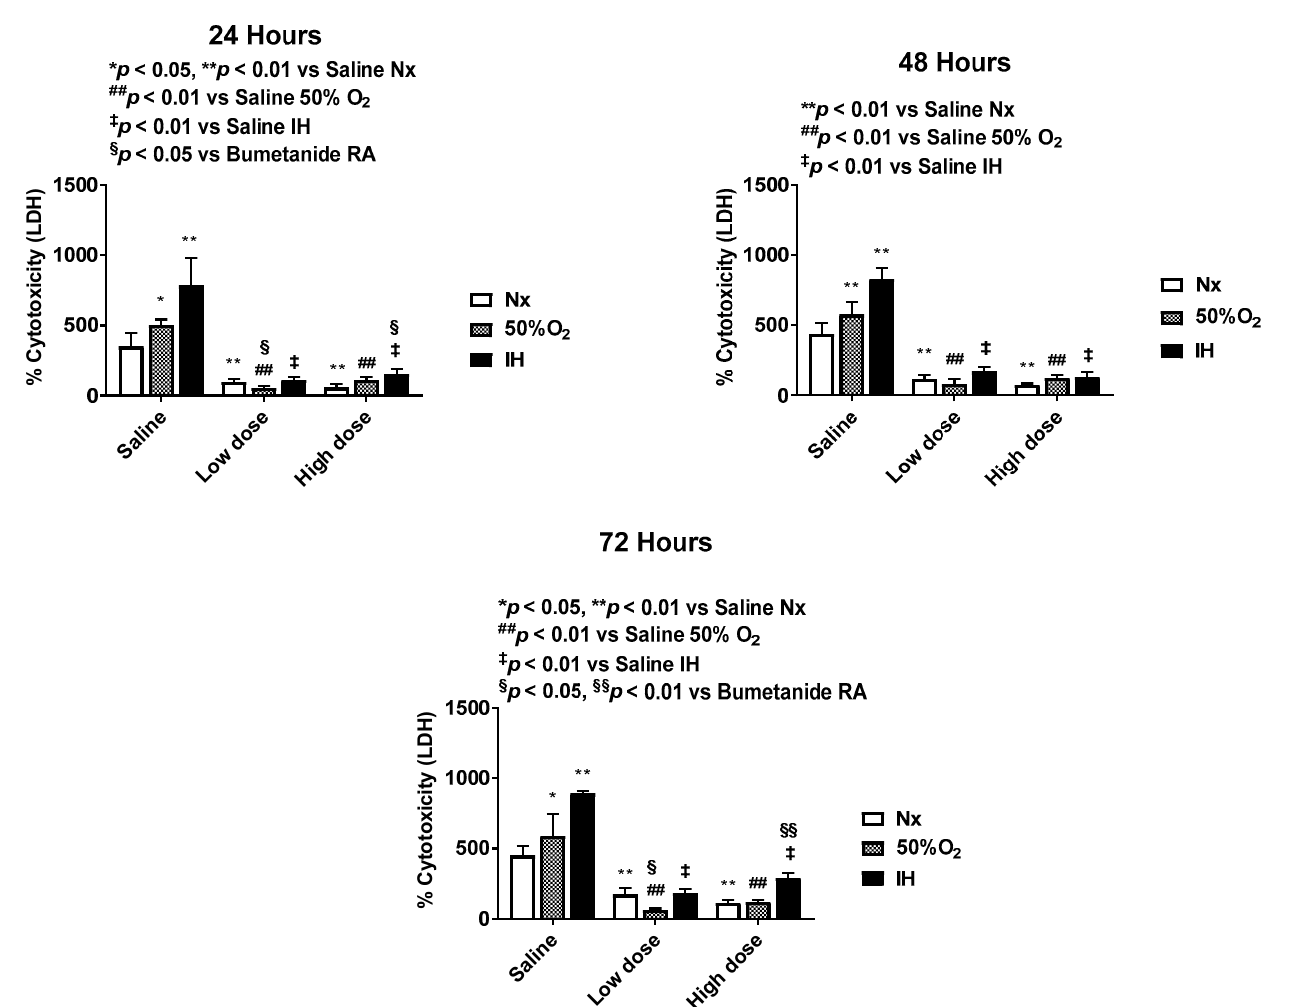
Figure 2. Dose-response effect of bumetanide on % cytotoxicity in the media from cultured human microvascular retinal endothelial cells (HMRECs) exposed to normoxia (white bar), hyperoxia (50% O 2 , shaded bar), or intermittent hypoxia (IH, black bar) for 24, 48, or 72 h. Cytotoxicity was determined using the lactate dehydrogenase (LDH) assay. Data were analyzed using two-way ANOVA with Dunnett’s post hoc test. Data are mean ± SEM (8 samples/group). * p < 0.05, ** p < 0.01 versus saline RA; ## p < 0.01 versus saline 50% O 2 ; ‡ p < 0.01 vs. saline IH; and § p < 0.05, §§ p < 0.01 versus bumetanide treatment in RA.